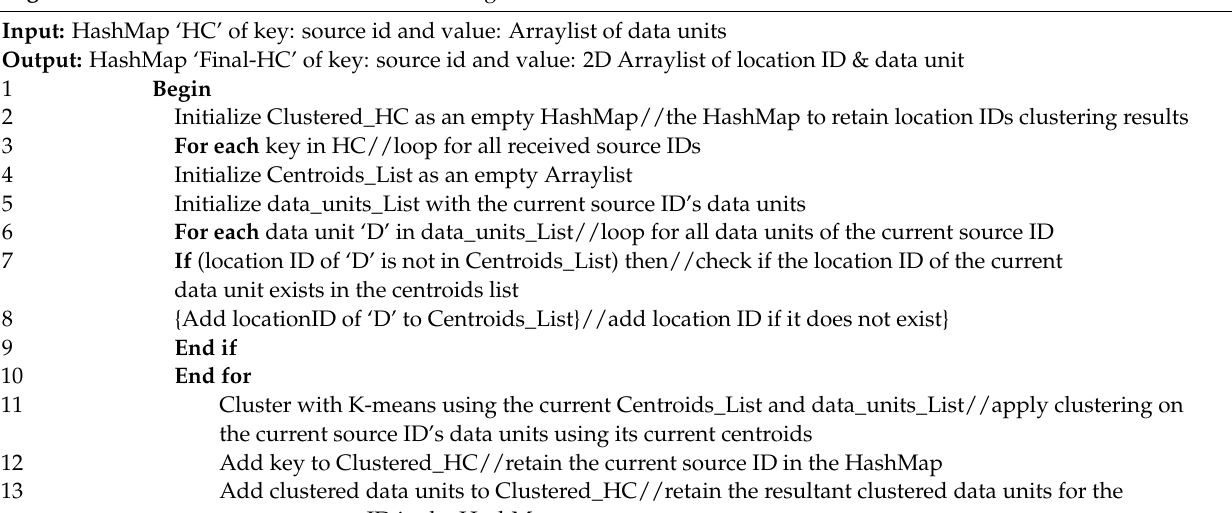
Algorithm 2: STDF IoT-based Data Fusion Manager.